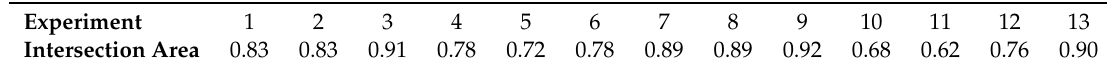
Table 3. Intersection areas of the histograms shown in Figure 7.